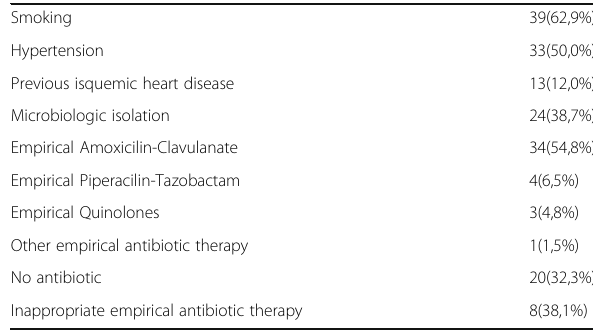
Table 89 (abstract